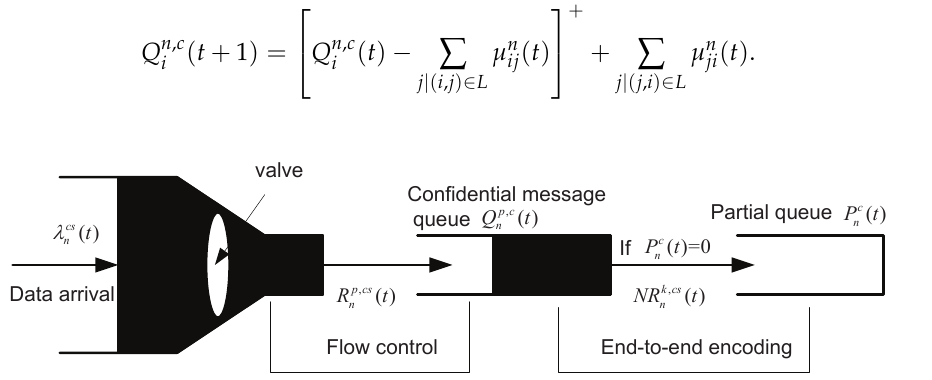
Figure 2. Queues of source nodes for finite secrecy